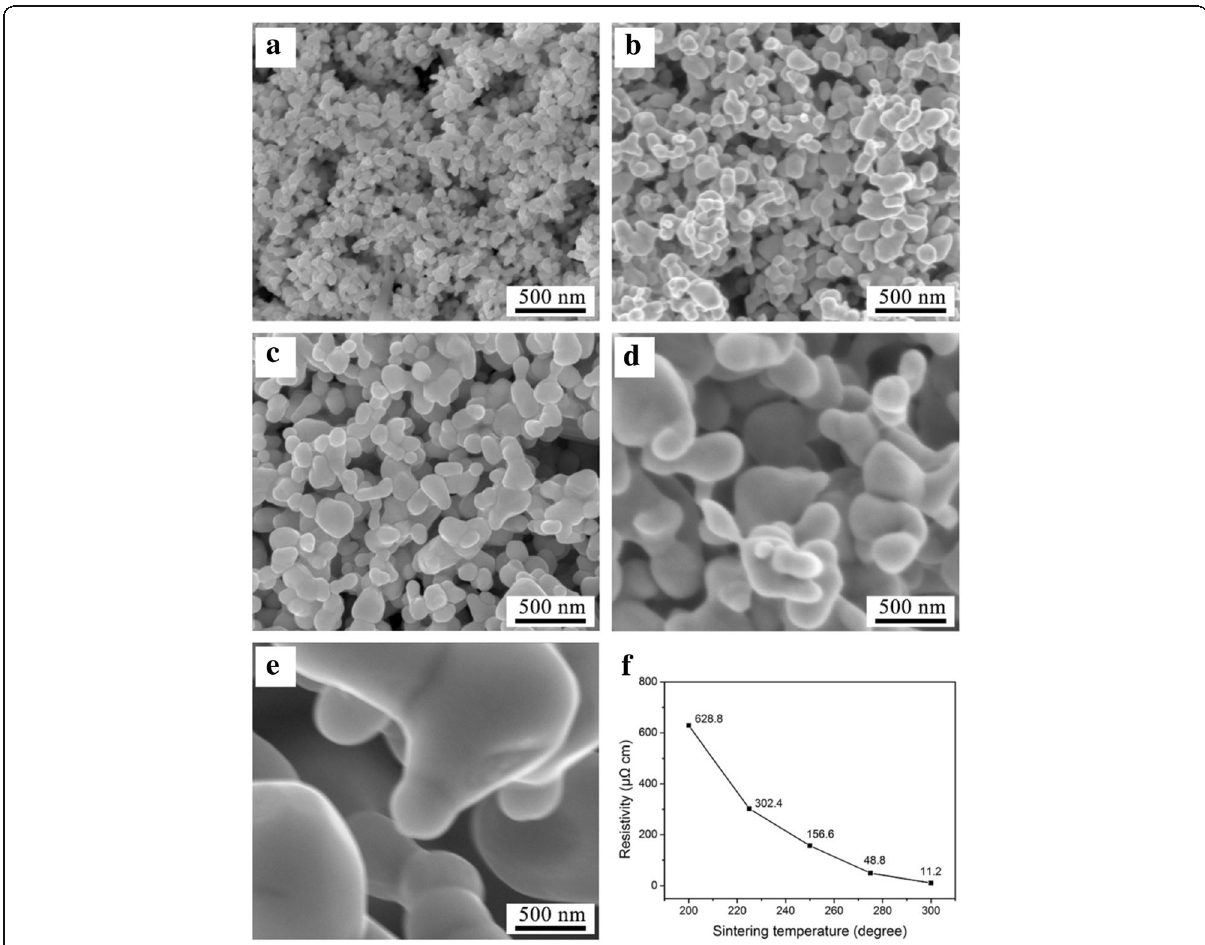
Fig. 2 The SEM images of the sintered nanoparticle pastes after sintering at a 200, b 225 °C, c 250, d 275, and e 300 °C. f The variation of resistivity with the increasing of sintering